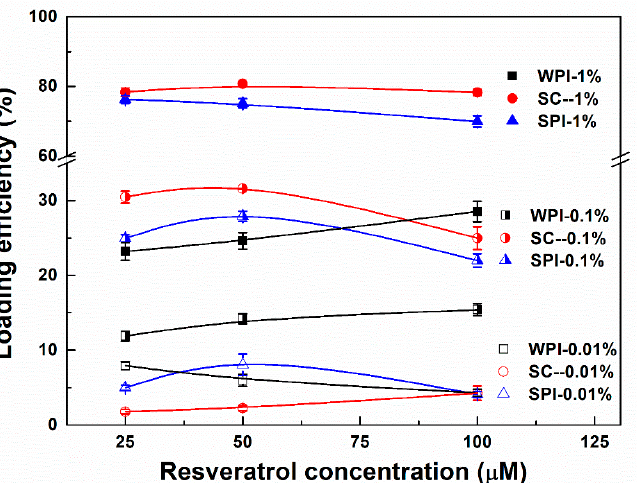
Figure 5. Loading efficiency of resveratrol in its complex particles with WPI (black), SC (red) and SPI (blue) at 0.01%, 0.1% and 1%.